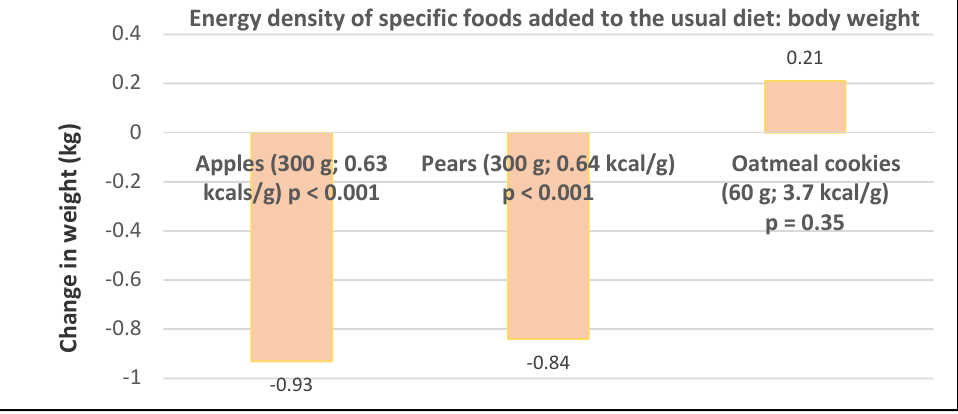
Figure 10. Apples or pears vs. oatmeal cookies added to the usual diet and weight change in 49 overweight and obese women (mean age 44 years) for ten weeks [41].